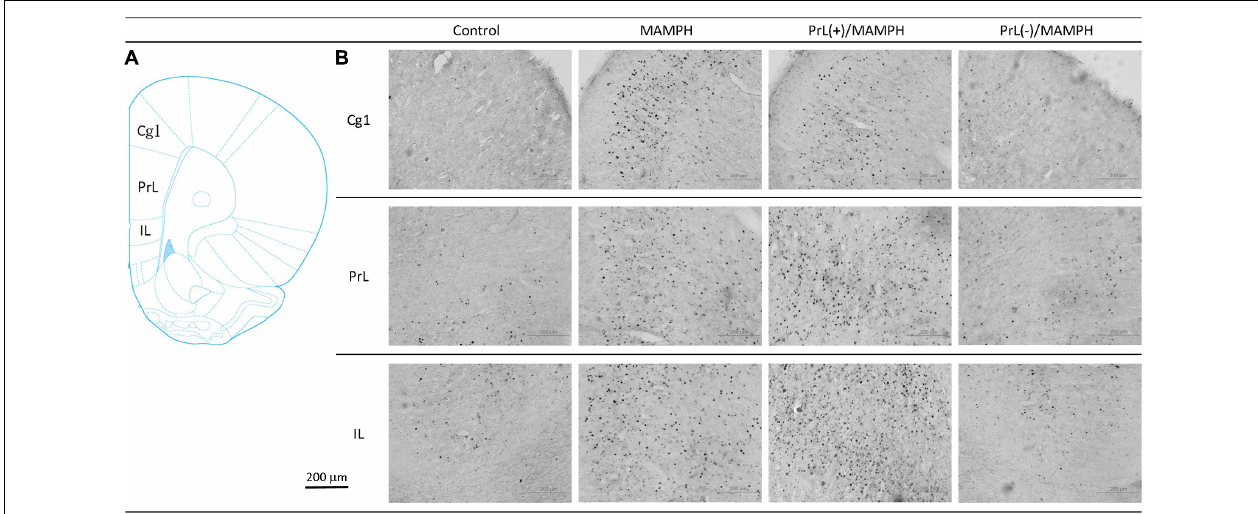
FIGURE 4 | (A) A schematic brain atlas for the Cg1, PrL, and IL of the mPFC. (B) Representative photomicrographs of c-Fos expression for the Cg1, PrL, and IL in the control, MAMPH, PrL(+)/MAMPH, and PrL(–)/MAMPH groups. The scale bar represents 200 µ